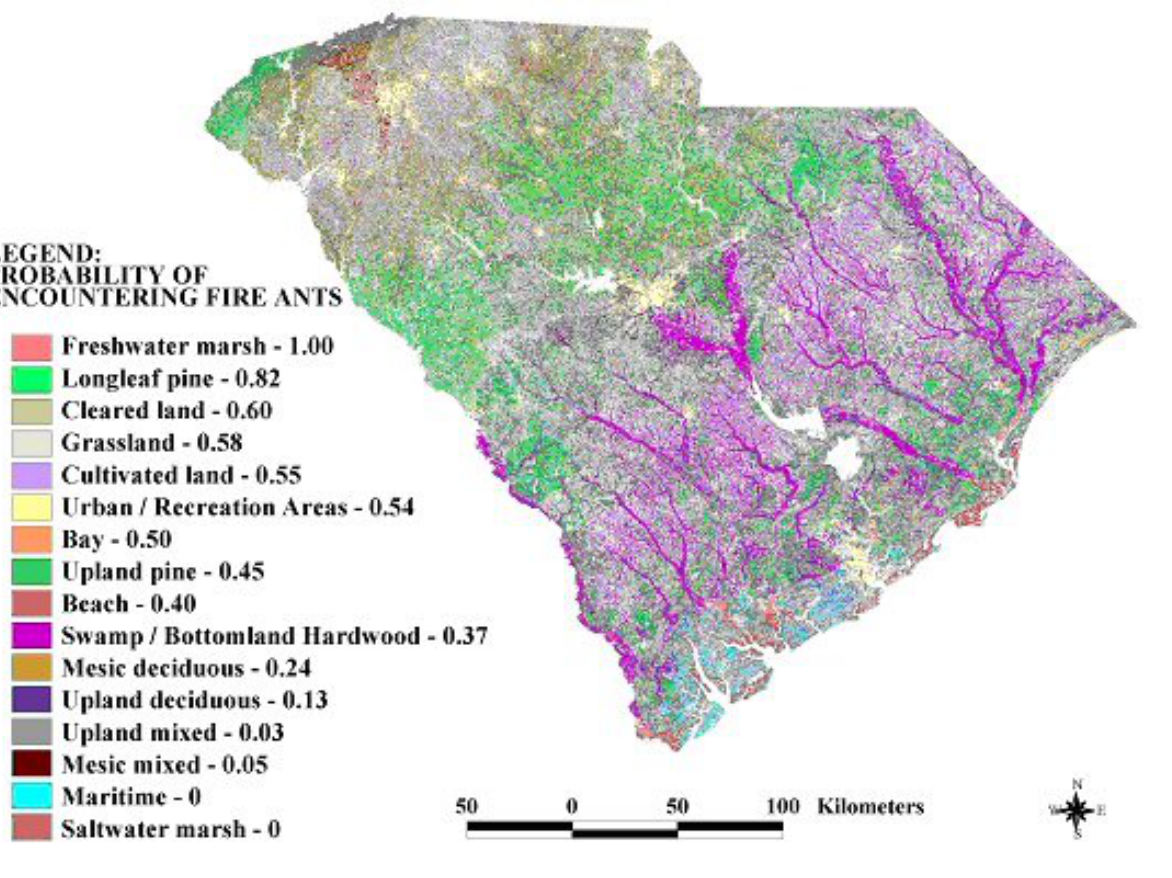
Fig. 2. Predicted fire ant distribution map for the state of South Carolina, USA, based on calculated probability of fire ant encounter during fire ant sampling, 1999-2000. This model was produces a “probability of presence landscape” based on sample proportions, and is generated by assigning each grid cell a probability of presence of fire ants based on percent presence within any given habitat